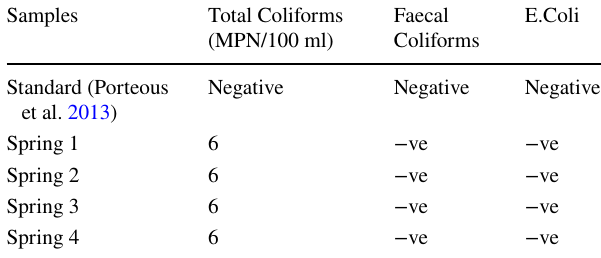
Table 4 Microbiological analysis